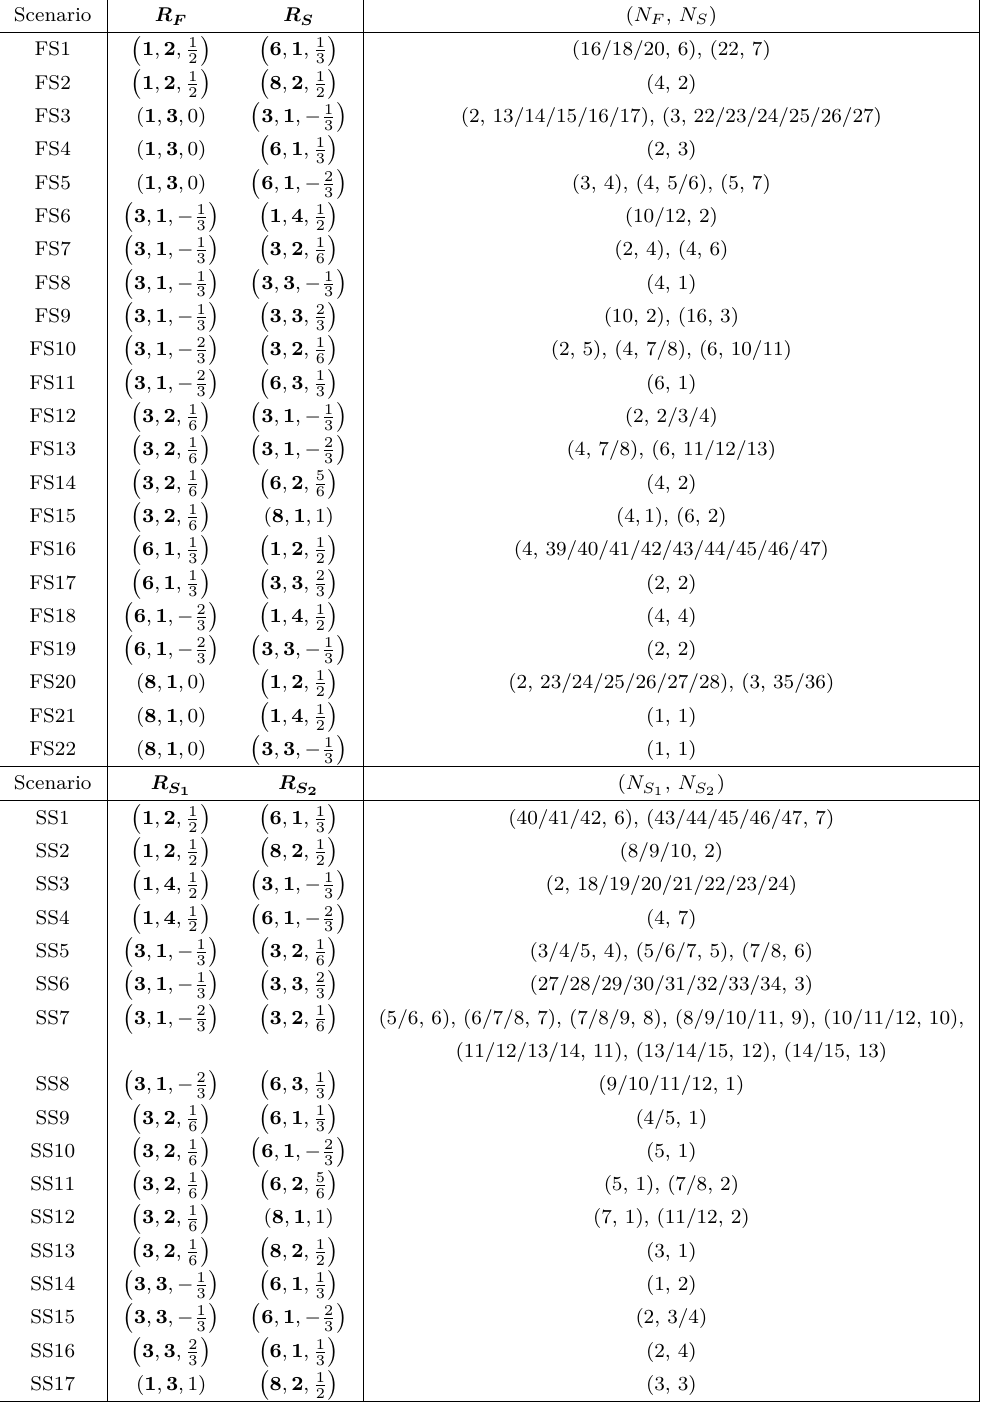
Table 5 . FS and SS extensions of the SM, which allow for the PGU ( (cid:15) GUT ≤ 1% ) at the unification scale 10 15 – 10 18 GeV and are not excluded by the SK measurement of the proton lifetime [35]. The BSM masses lie in the range 0 . 25 – 10 TeV . In columns 2 and 3 quantum numbers of the new particles w.r.t. the SM gauge group are given. Column 4 displays possible numbers of identical copies of fermions and scalars in each representation.